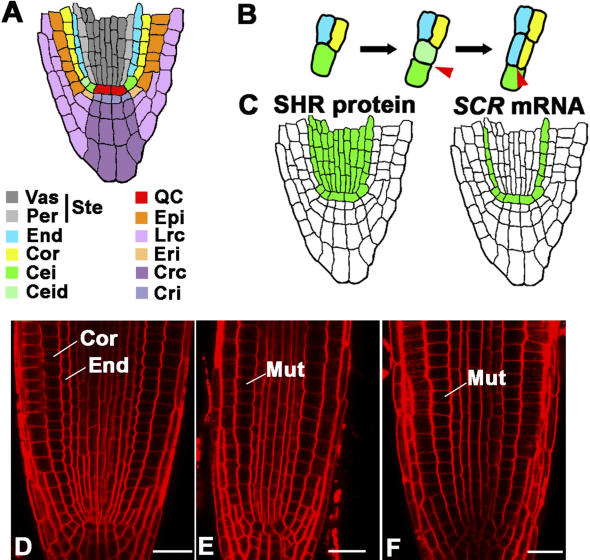
The
SHR Pathway Is Essential for Stem Cell Specification and Radial Patterning of the Root
(A) Schematic of a transverse section showing
Arabidopsis root anatomy. Cei, cortex-endodermis initials; Ceid, cortex-endodermis initial daughters; Cor, cortex; Crc, columella root cap; Cri, columella root cap initials; End, endodermis; Epi, epidermis; Eri, epidermis-root cap initials; Lrc, lateral root cap; Per, pericycle; QC, quiescent center; Ste, stele; Vas, vascular cylinder.
(B) Diagram of the cell divisions that form endodermis and cortex. The color code is as in (A). The two arrowheads indicate the transverse division of the Cei and the longitudinal division of the Ceid.(C) The SHR and SCR domain. The SHR protein (left) is present in the stele, the endodermis, the QC, the Cei, and the Ceid.
SCR (right) is transcribed specifically in the QC, the Cei, and the Ceid.
(D–F) Confocal section of roots from 5-d-old wild-type (D),
shr-2 (E), and
scr-4 (F). Cor, cortex; End, endodermis; Mut, mutant layer. Scale bars: 25 μm.